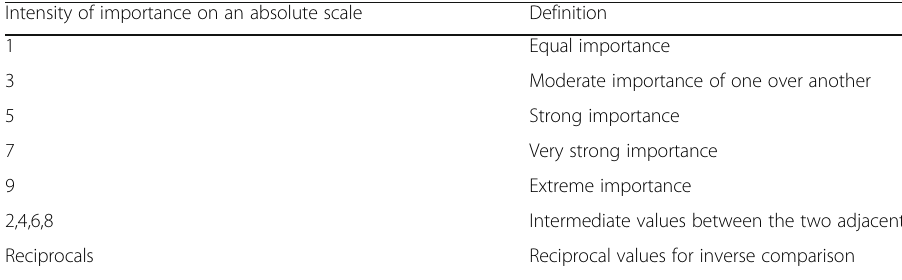
Table 6 The fundamental scales of AHP method Intensity of importance on an absolute